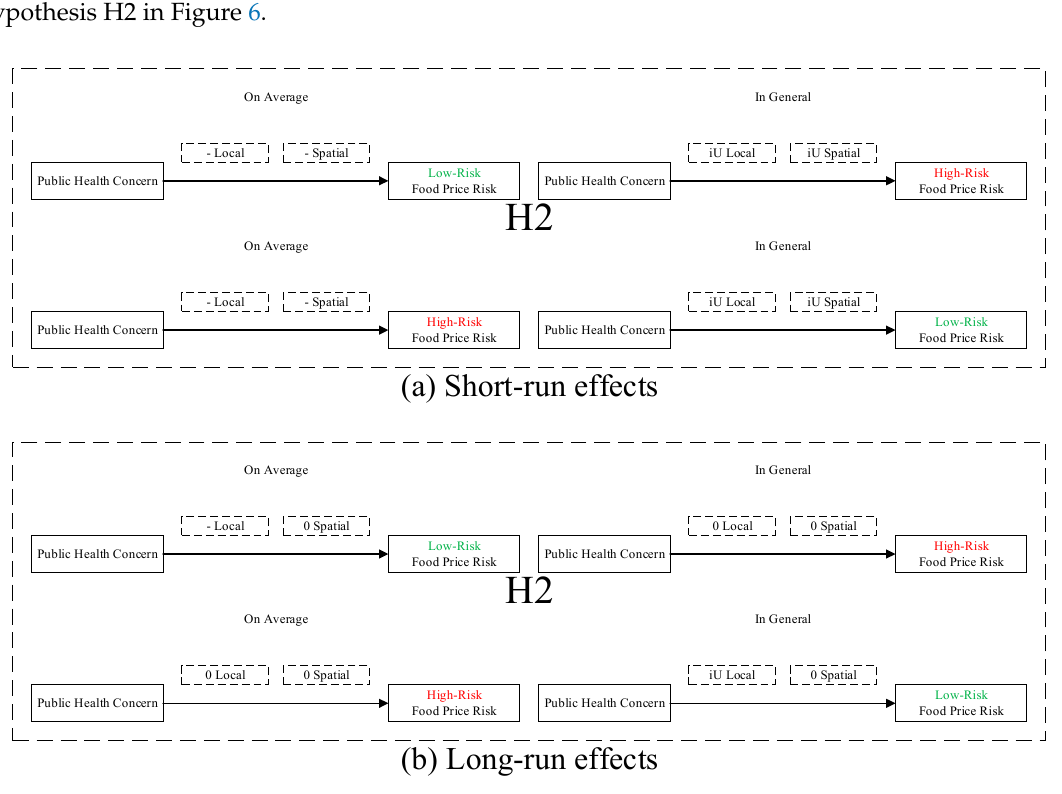
Figure 6. Test results for hypothesis H2. The symbols “0”, “-”, and “iU” show “insignificant”, “negative”, and “inverse U-shaped” spillovers, respectively. Source: Originally developed by the authors.